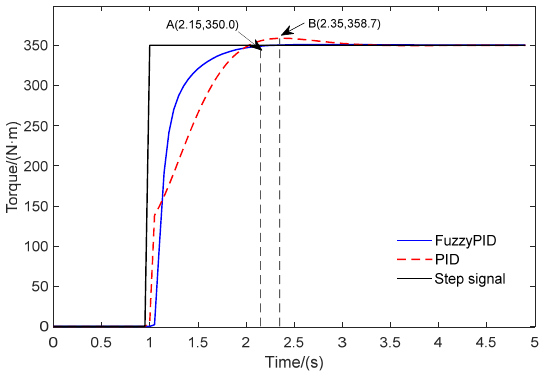
Figure 9. Simulation results of step response.